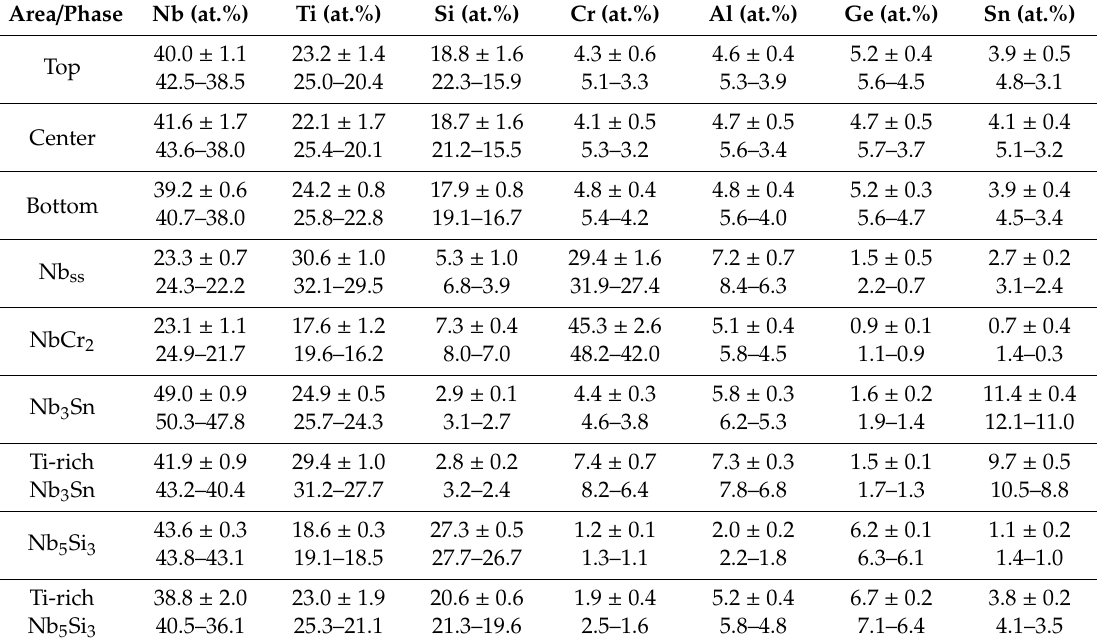
Table 1. Microanalysis data (at.%) of